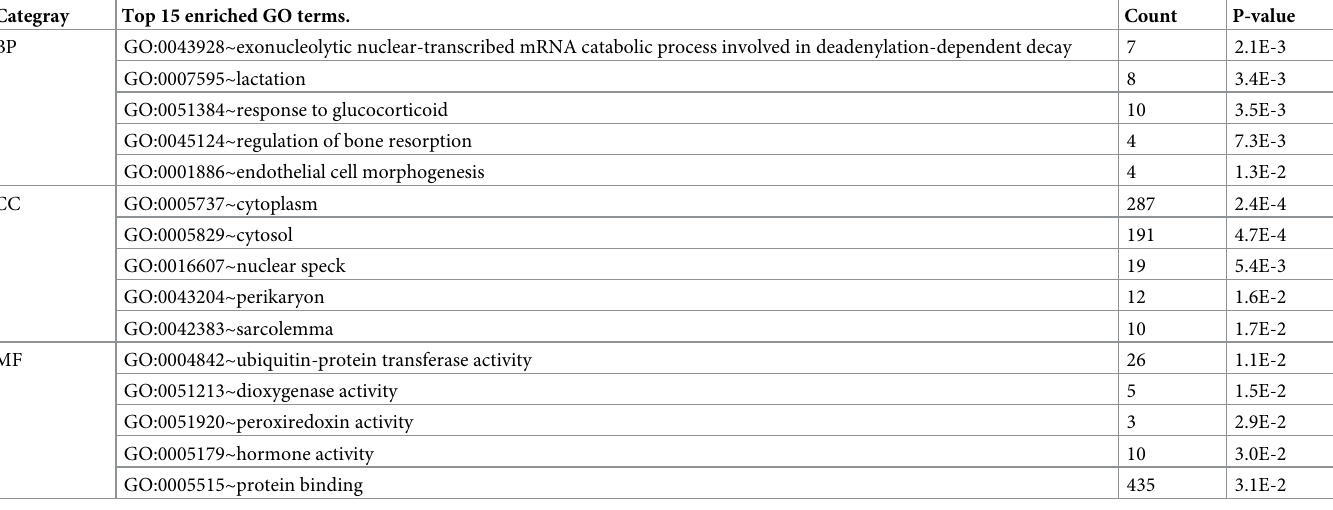
Table 1. Top 15 GO enrichment terms associated with genes in black module. Categray Top 15 enriched GO